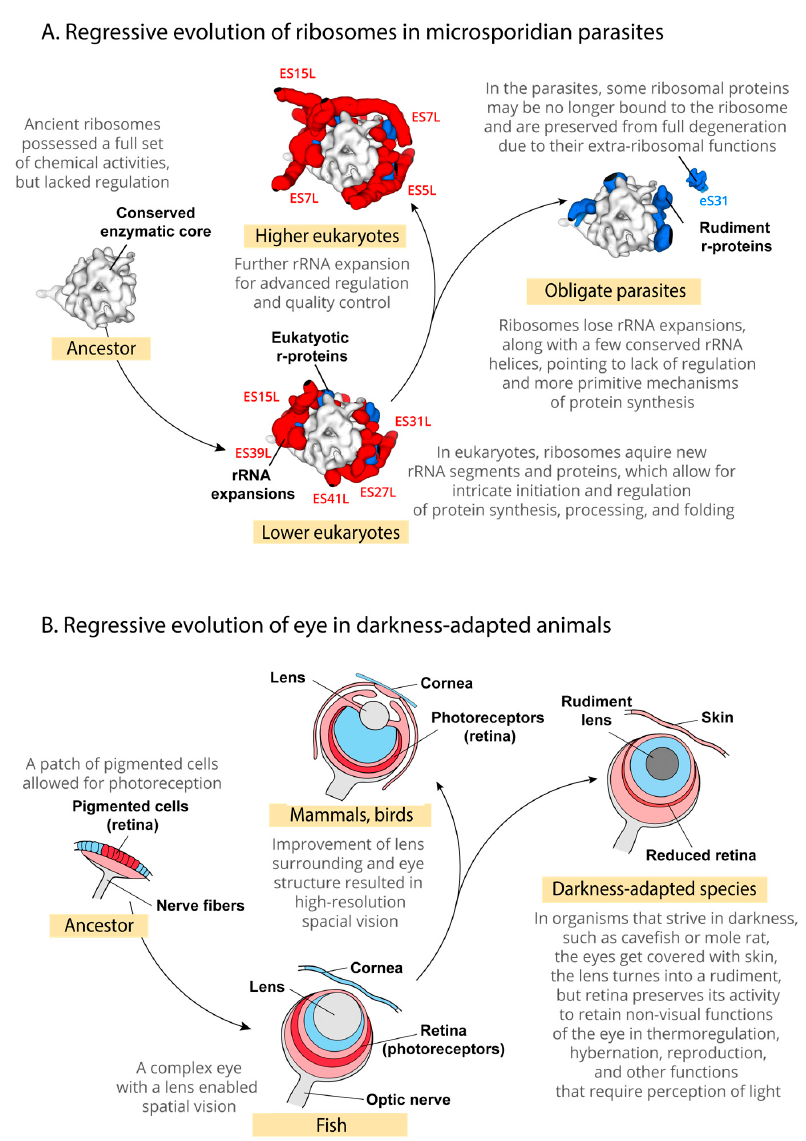
Figure 3. Degeneration of microsporidian ribosomes illustrates a remarkable similarity of regressive evolution at the scale of individual proteins and nucleic acids, and at the scale of organs of animal body. ( A ) Our study suggests that upon transition to parasitic lifestyle, microsporidian ribosomes not only have lost their rRNA expansions, but also transformed several ribosomal proteins from active players of ribosome assembly into dysfunctional rudiments. For instance, in non-parasitic eukaryotes, many ribosomal proteins are buried in the ribosome interior, where they stabilized interactions between the ancient core of the ribosome and rRNA expansions. In Microsporidia , these proteins (i.e., eS6, eS8, eS24, eL8, eL14, eL18, eL39) are expected to be exposed on the ribosomal surface where they have no apparent biological function. Other proteins, such as eS31, eL27, and possibly eS7, appear to become free standing proteins that are no longer associated with the ribosome in Microsporidia . However, eS31, eL27, and eS7 proteins are not eliminated from microsporidian proteomes, suggesting that these proteins may be retained in Microsporidia for their extra-ribosomal functions. ( B ) A schematic path of eye evolution shows that similar regressive changes occur during animal adaptation to darkness, as observed in cavefish and mole rats. Importantly, although the eye of darkness-adapted animals is blind and is filled with many rudiments (e.g., the non-functional degenerated lens), it retains the light-sensitive retina that fulfils the non-visual functions of light perception to control animal hibernation, mating, and thermoregulation